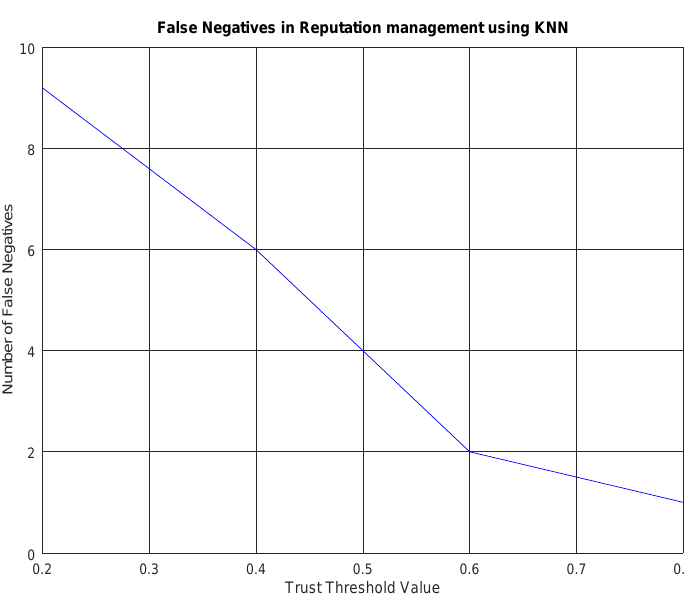
Figure 10. Reputation management using KNN.